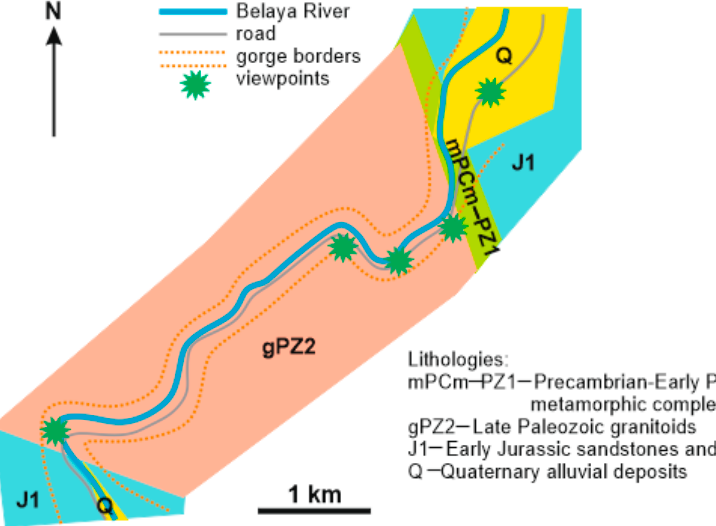
Figure 2. Geographical plan and geology of the Granite Gorge.